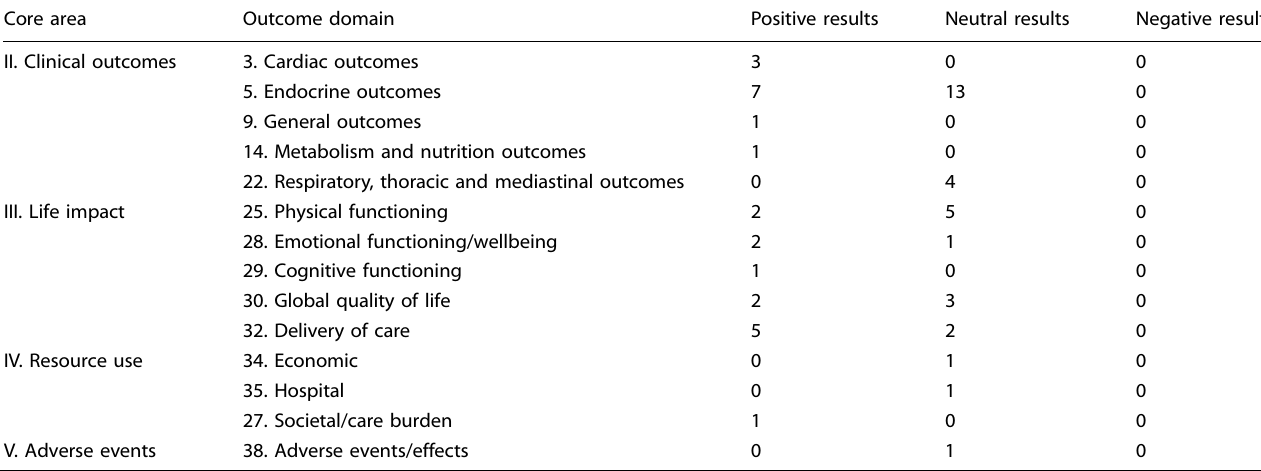
Table 3. Primary outcome domains and statistical signi fi cance ( α ≤ 0.05) of the included studies ( n = 56). Core area Outcome